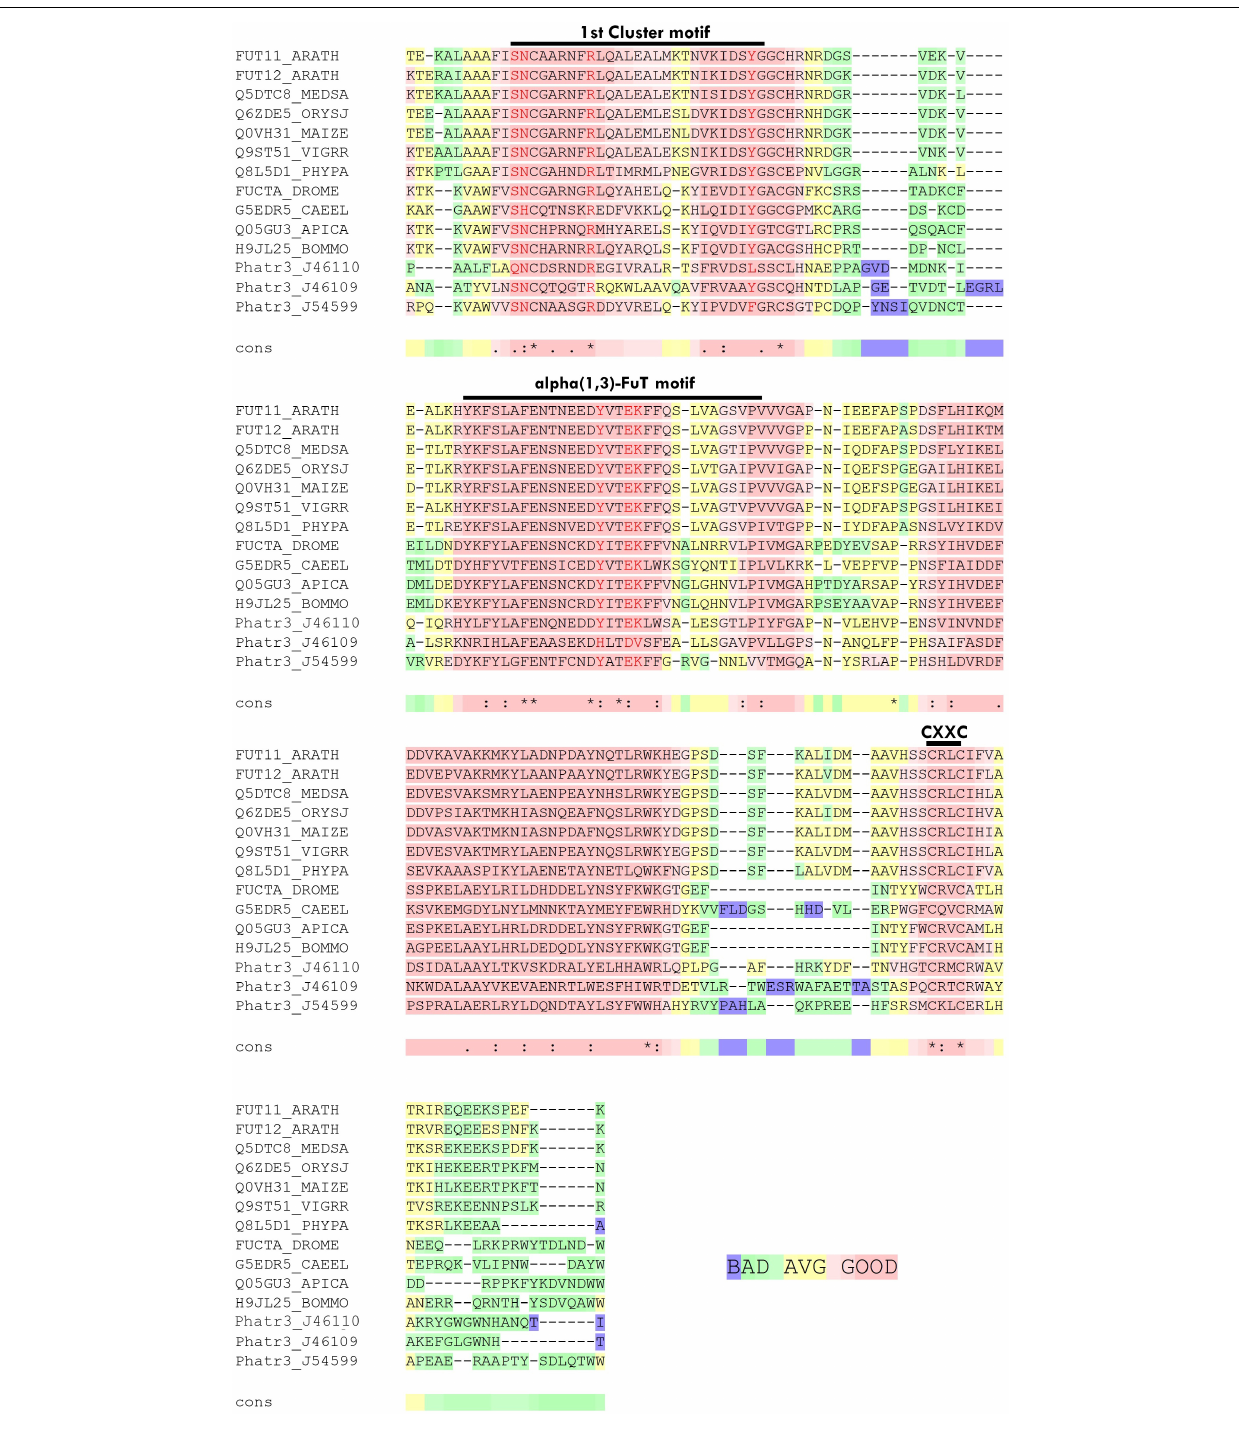
Frontiers in Plant Science |